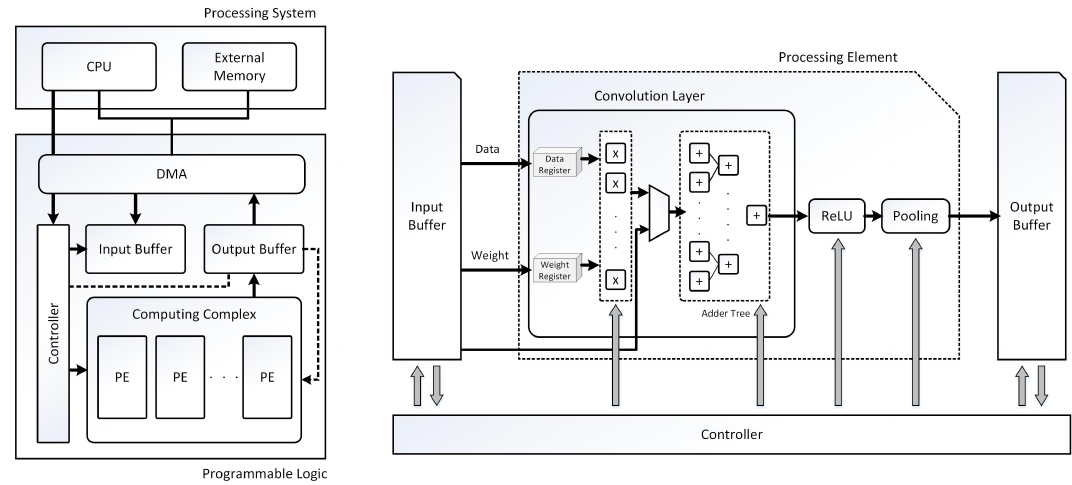
Figure 1. FPGA-based CNN accelerator architecture. PE, processing